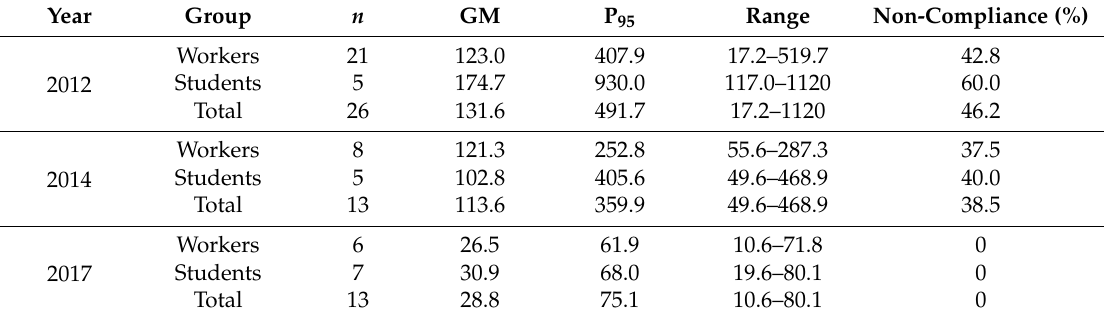
Table 4. Geometric mean concentrations (range) of FA ( µ g/m 3 ) of full work-shift measurements in the breathing